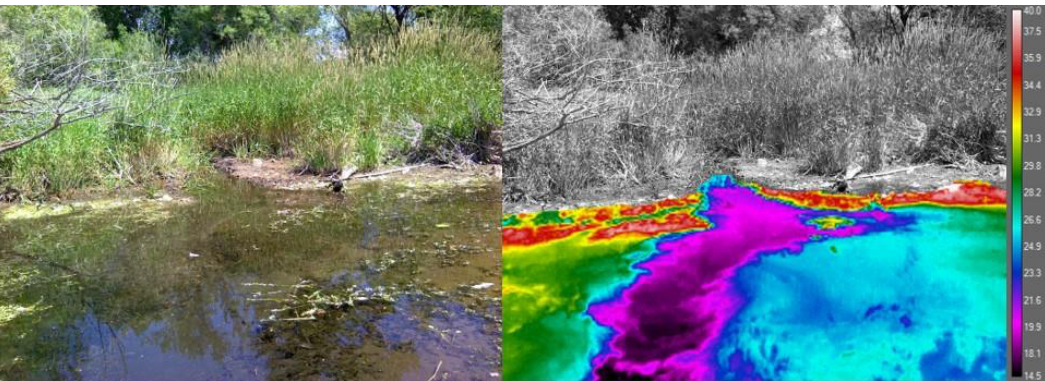
Figure 6. A side-by-side comparison of a visual image ( left ) and thermal infrared image ( right ) of the area where outflow from a groundwater spring located at 43°57 ’ 07.6 ” N 111°43 ’ 26.7 ” W entered a side channel of the river (flowing right to left). The photo was taken from a point 1.5 m from the margin of the side channel, looking toward the spring confluence. The spring emerged from the ground ~30 m from the confluence point. Temperature is indicated in °C.